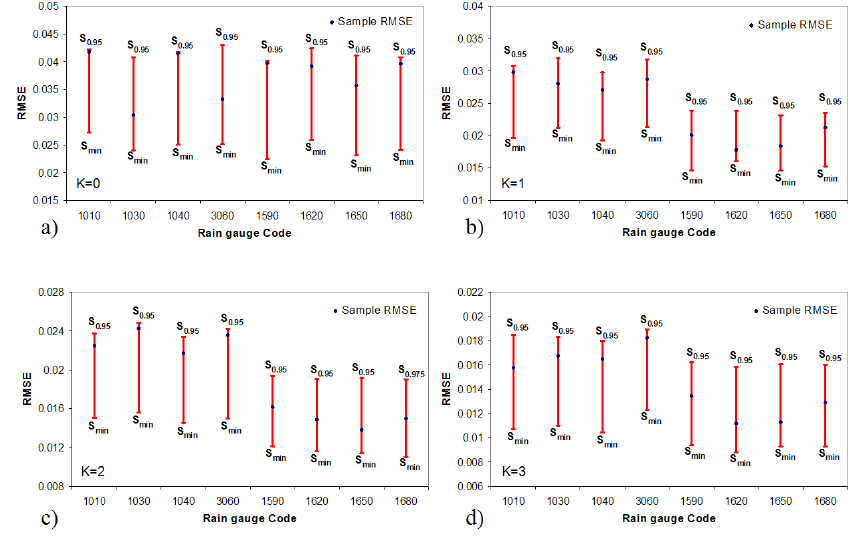
Fig. 10. Sample root-mean-square error (RMSE) and 95% one-tailed confidence intervals, for K = 0 (a) , K = 1 (b) , K = 2 (c) and K = 3 (d)